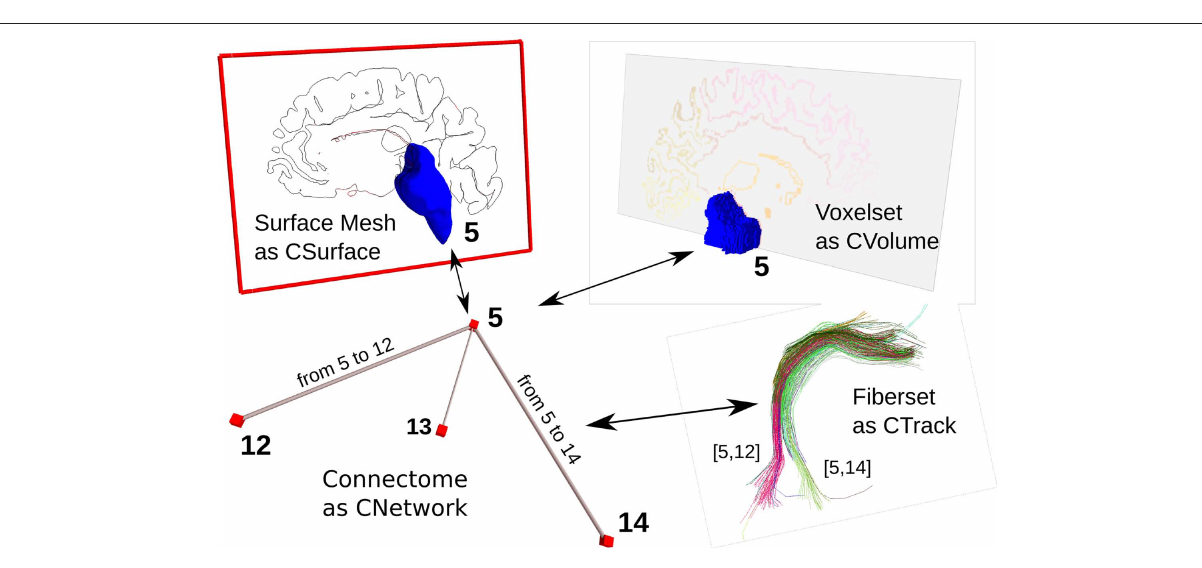
Figure 4 | relationship between multi-modal connectome objects. Correspondence is established with unique (integer) identifiers between the nodes of a network, the ROI in a volumetric dataset, and the surface mesh. Analogically, a network edge has the same identifier as the fiber tracts that connect such two brain